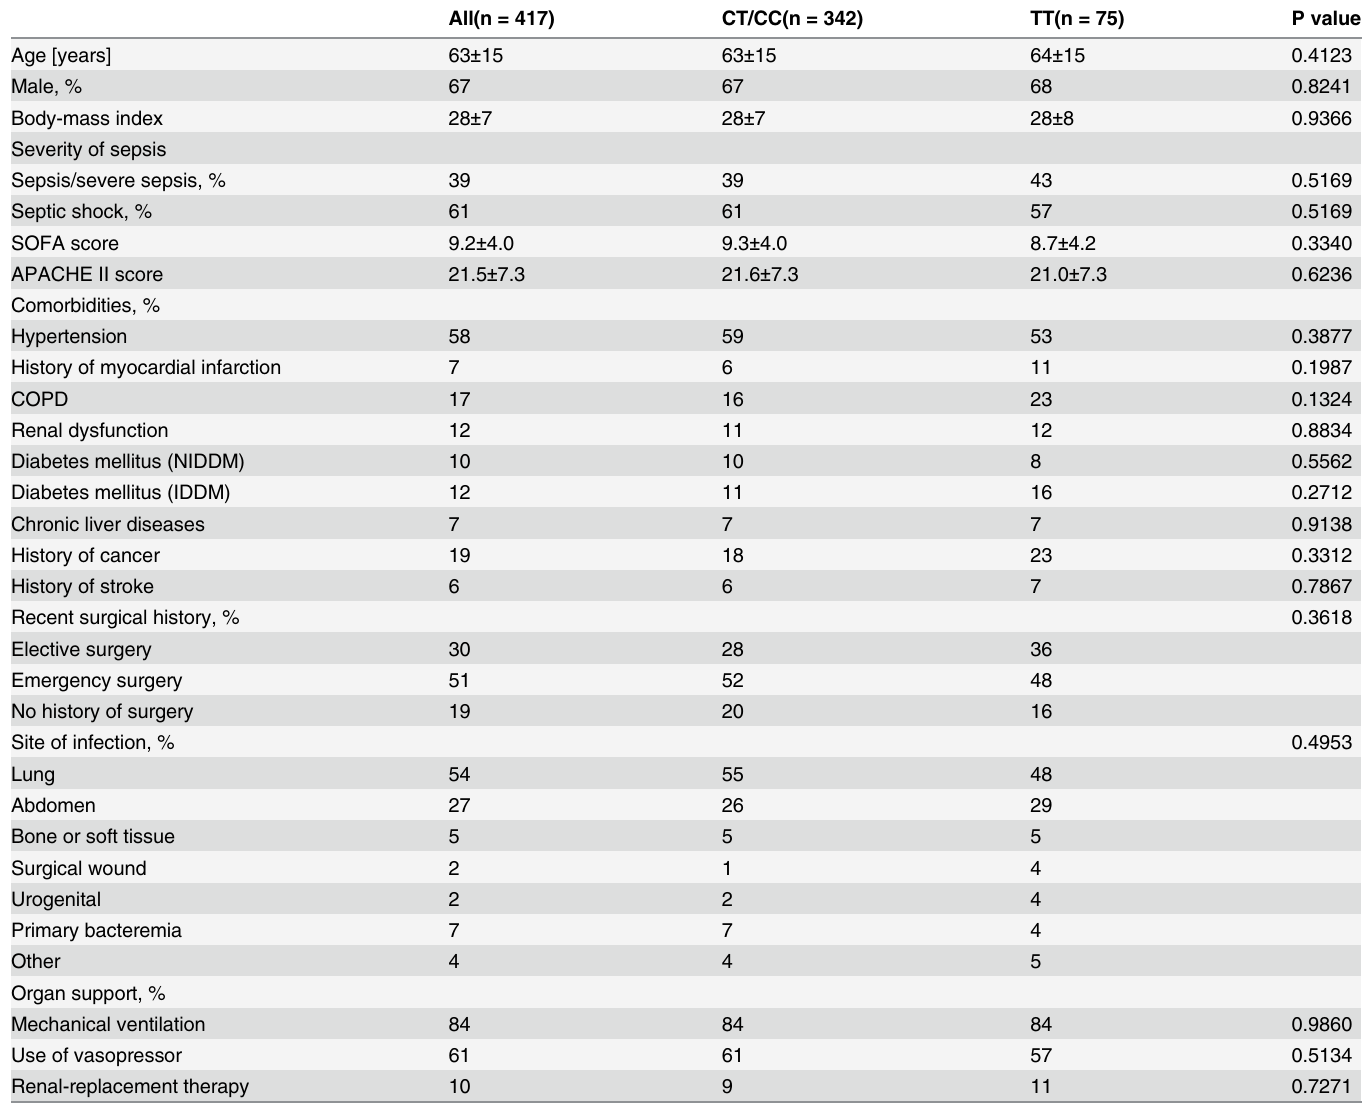
Table 1. Patient baseline characteristics according to CD14 rs2569190